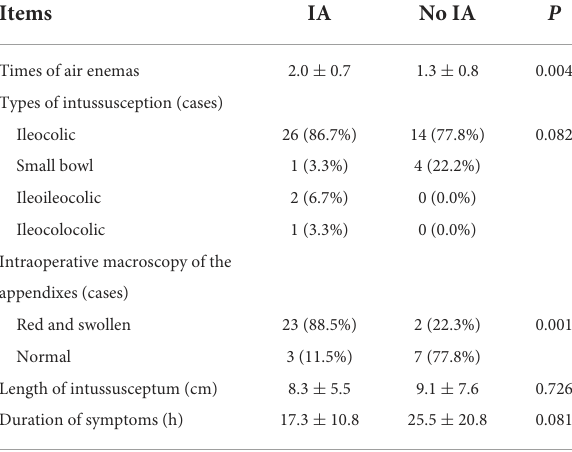
TABLE 3 The factors which may influence surgeons’